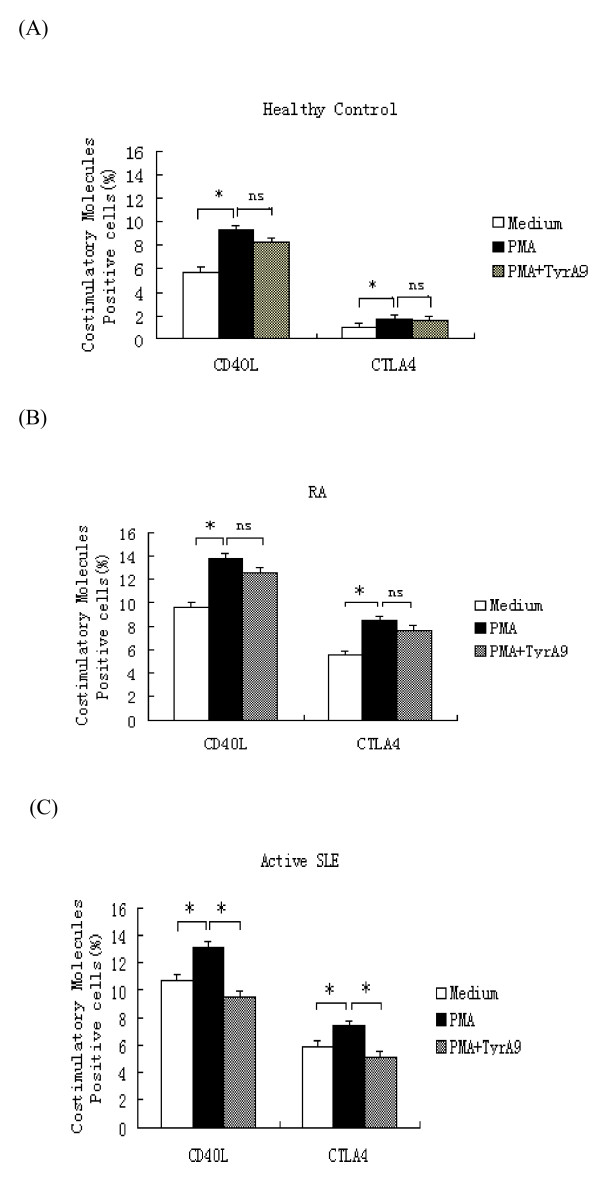
Up-regulation of CD40L and CTLA-4 by PYK2 activation in PBMCs from patients with active SLE (C), but not those from normal individuals and RA patients (A and B). PBMCs were incubated for 24 h with medium, PMA (1 ng/ml) or pretreated with the PYK2 inhibitor TyrA9 (5 μM) for 1 h before the addition of PMA, and then analyzed for the expression of CD40L and CTLA4 by flow cytometric analysis. All experiments were repeated at least three times with similar results. Statistical analysis: * = p < 0.05.